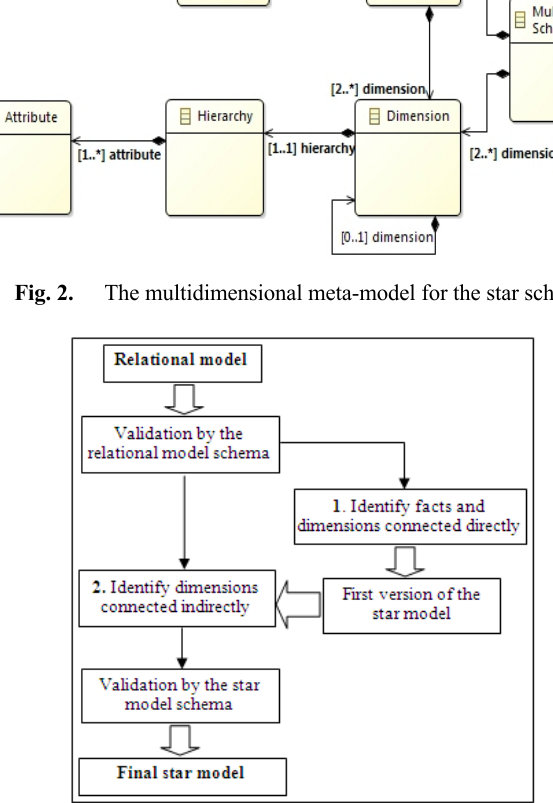
Fig. 3. The steps of the X-ETL